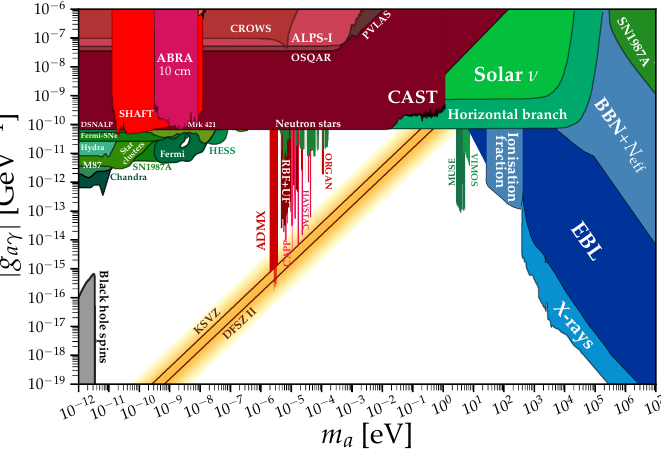
Figure 1. ALPs parameter space with current constraints (last update: July 2020). The collected limits, references and plots are available in the git-hub repository: https://cajohare.github.io/AxionLimits/ (accessed on 3 June